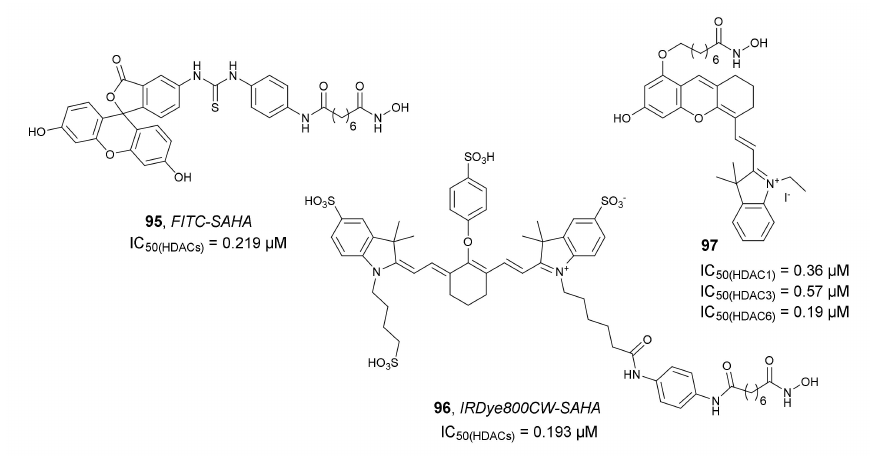
Figure 33. Chemical structures of FITC-SAHA 95 , IRDye800CW-SAHA 96 , and compound 97 .